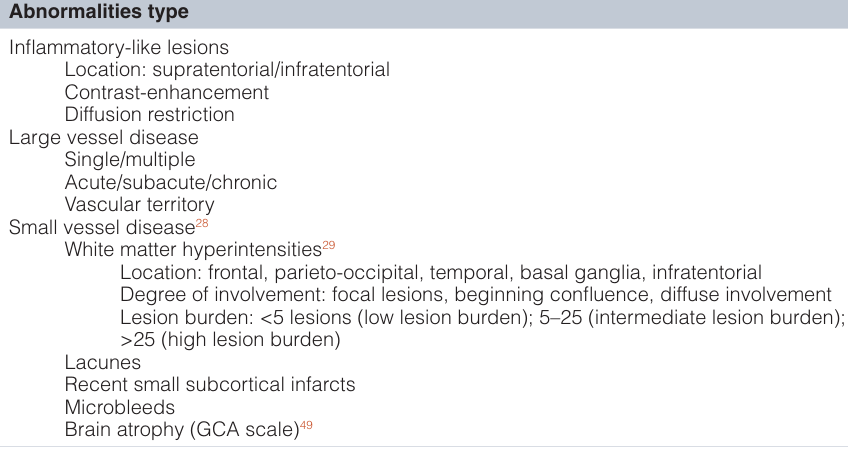
Table 1. Magnetic resonance imaging classification proposed for brain abnormalities in patients with neuropsychiatric lupus.